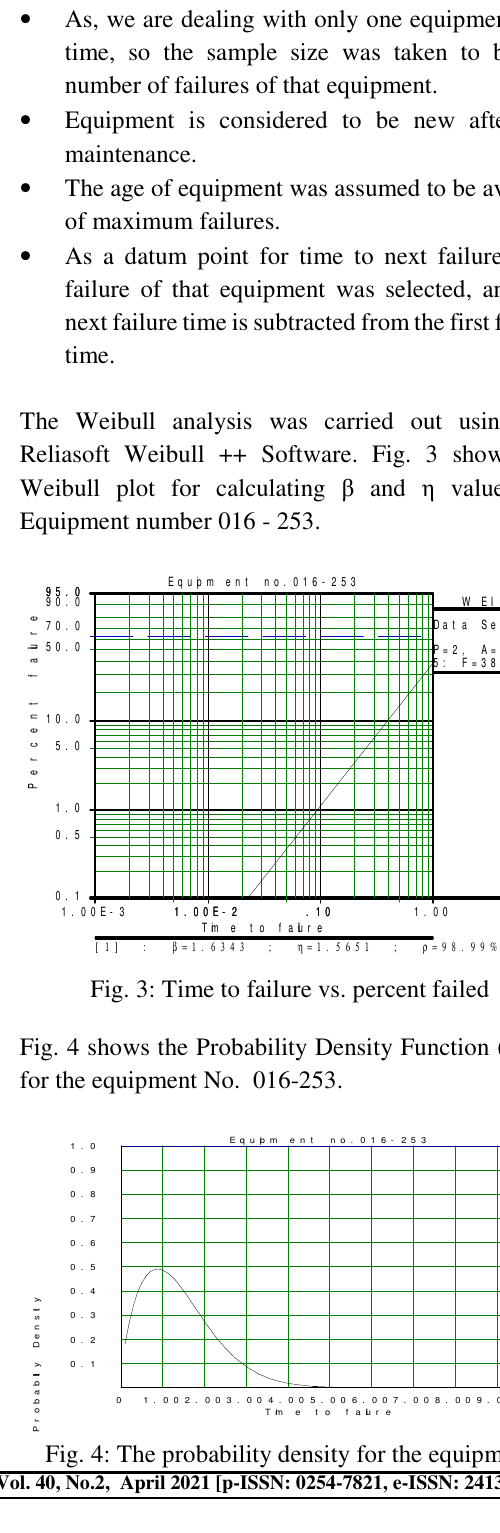
Table 2: Equipment Name and Age Equipment No.